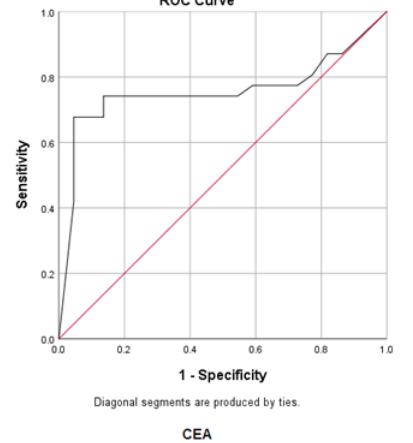
Fig. 3. ROC curve for CEA.